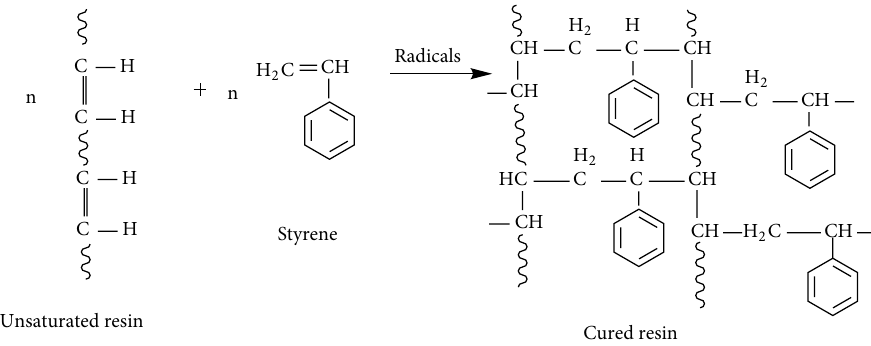
Figure 1: Anchoring agent curing reaction chemical